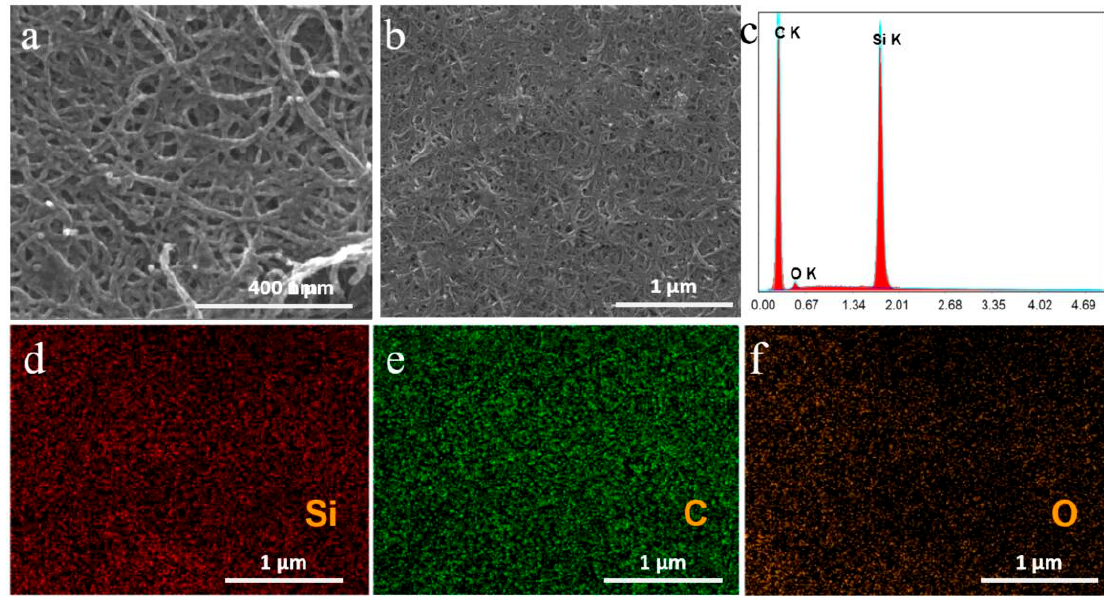
Figure 5. ( a , b ) SEM images of Si/SiC/CNT nanocomposite; ( c ) EDX spectrum of Si/SiC/CNT nanocomposite. Element mappings of Si/SiC/CNT nanocomposite: Si ( d ); C ( e ); O ( f ).